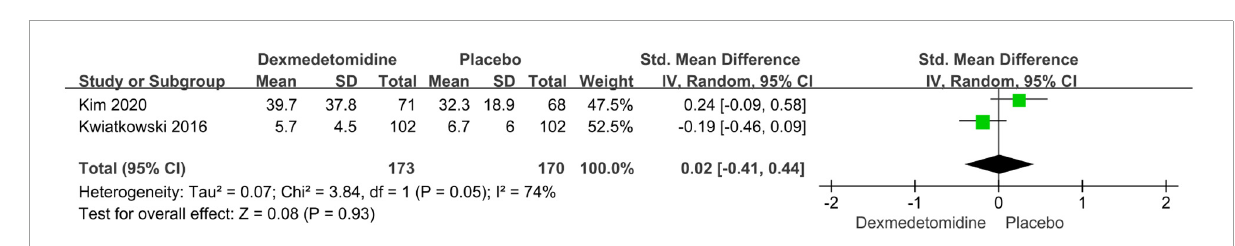
FIGURE7 Pooled result of postoperative length of ICU stay between dexmedetomidine and placebo groups.